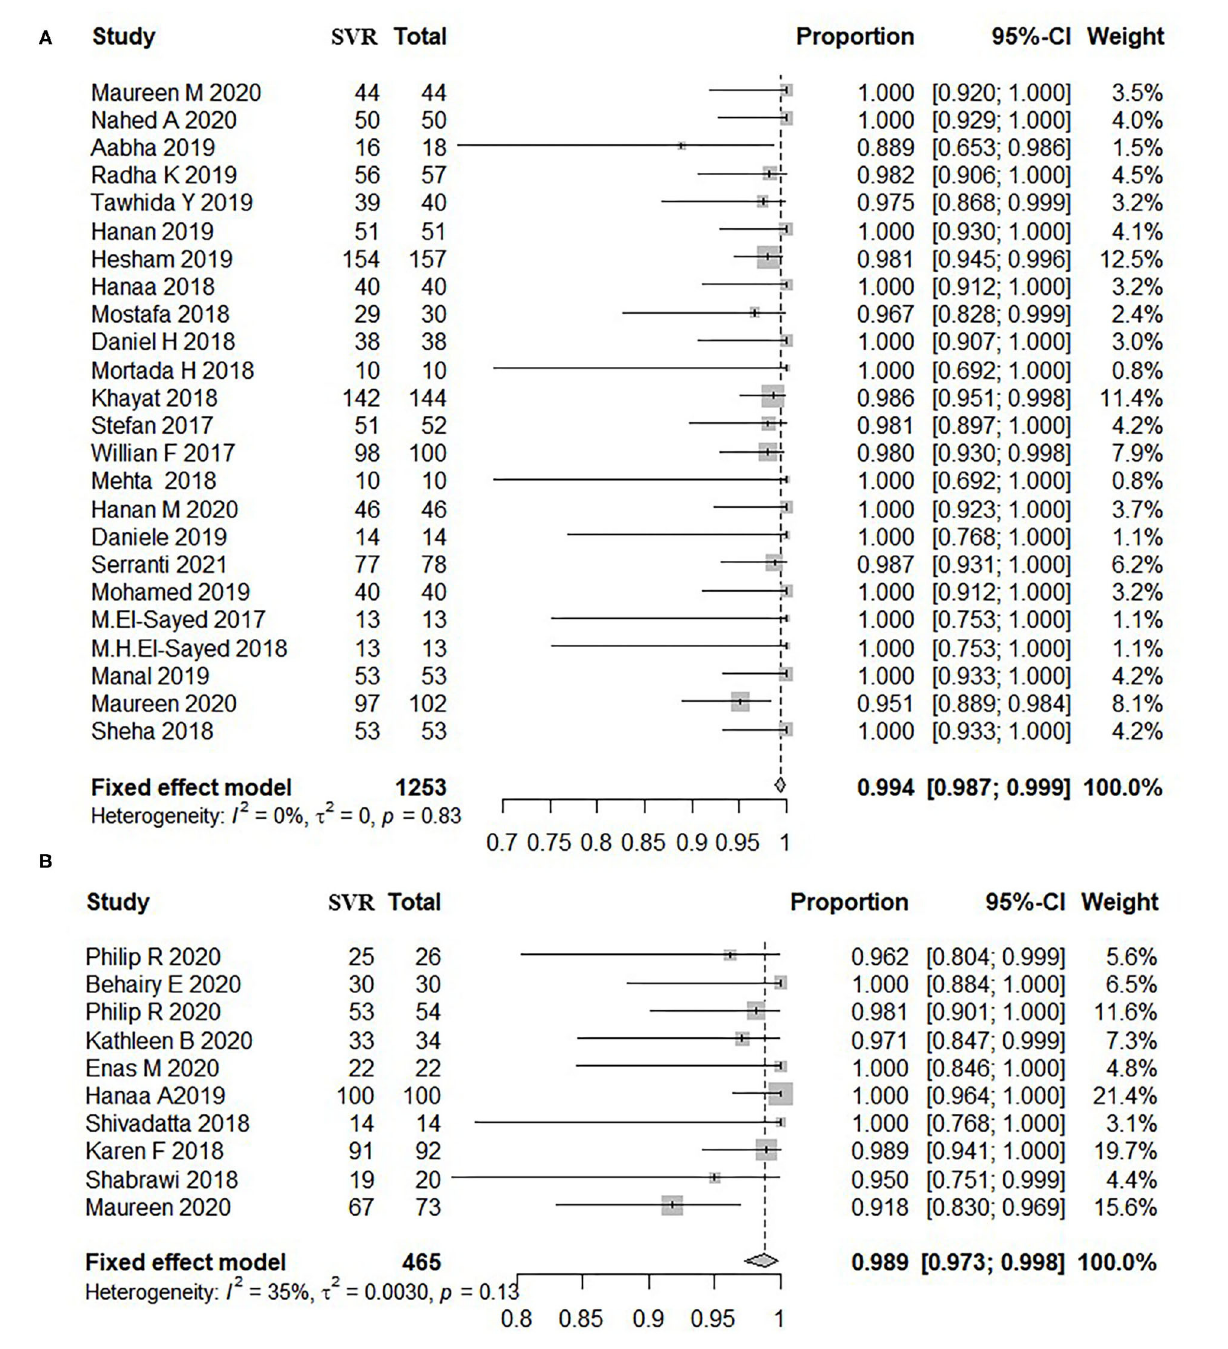
weeks of glecaprevir/pibrentasvir (G/P) is equally effective in treatment-naive non-cirrhotic adults (63). We did not detect any significant differences between the various treatment durations